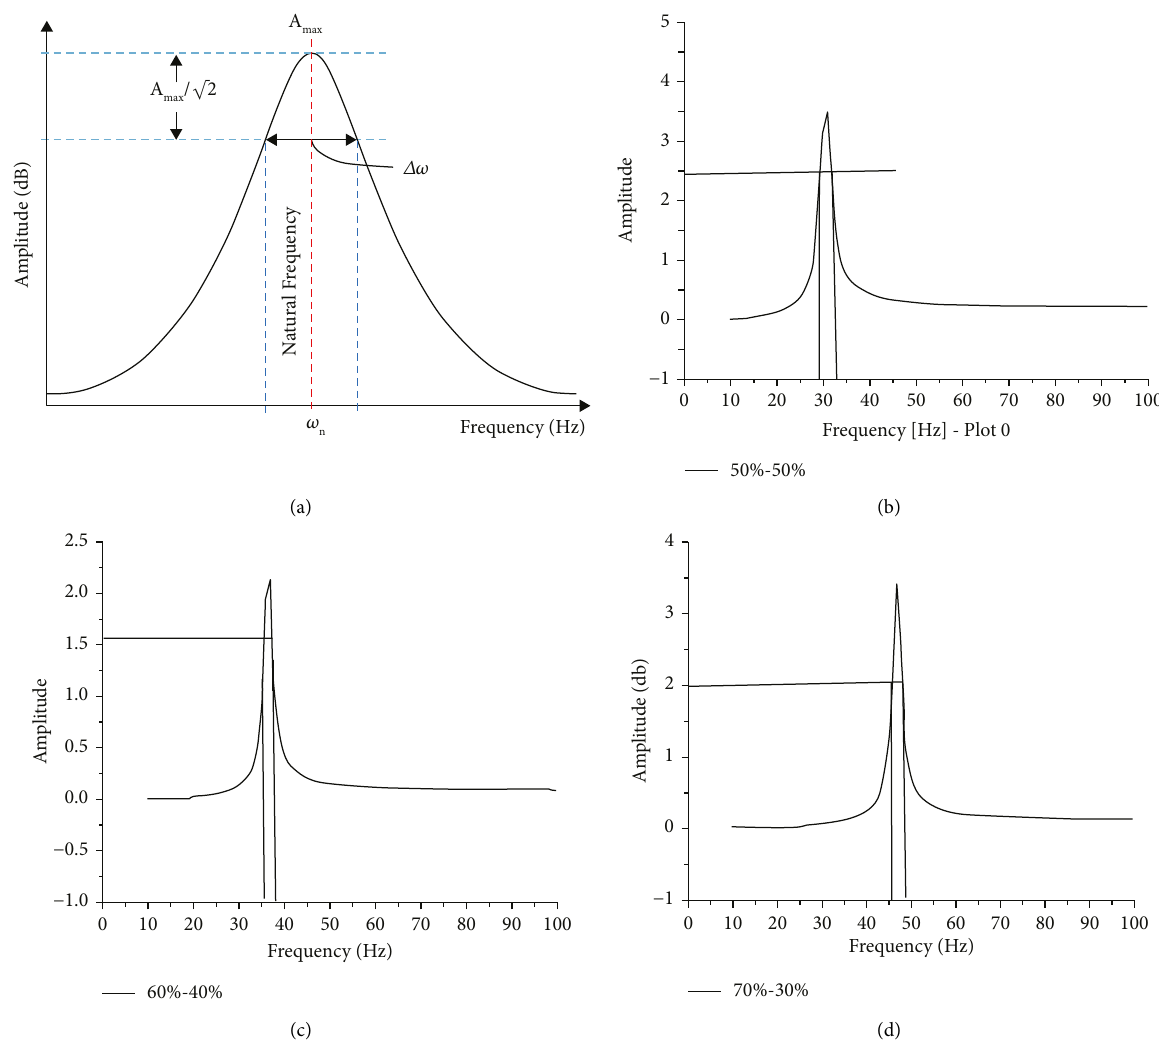
Figure 9: (a) Half power bandwidth graph; frequency v/s amplitude curve of (b) 50-50%, (c) 60-40%, and (d) 70-30% glass/epoxy composites for Mode 1. Table 3: Dimensions and properties of glass/epoxy composite